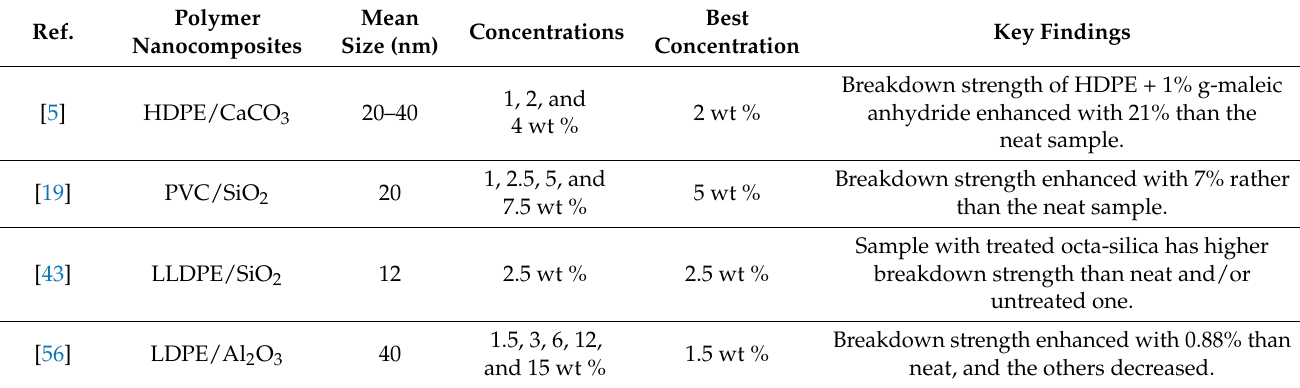
Table 1. AC breakdown strength of polymer nanocomposites based on PE and PVC.